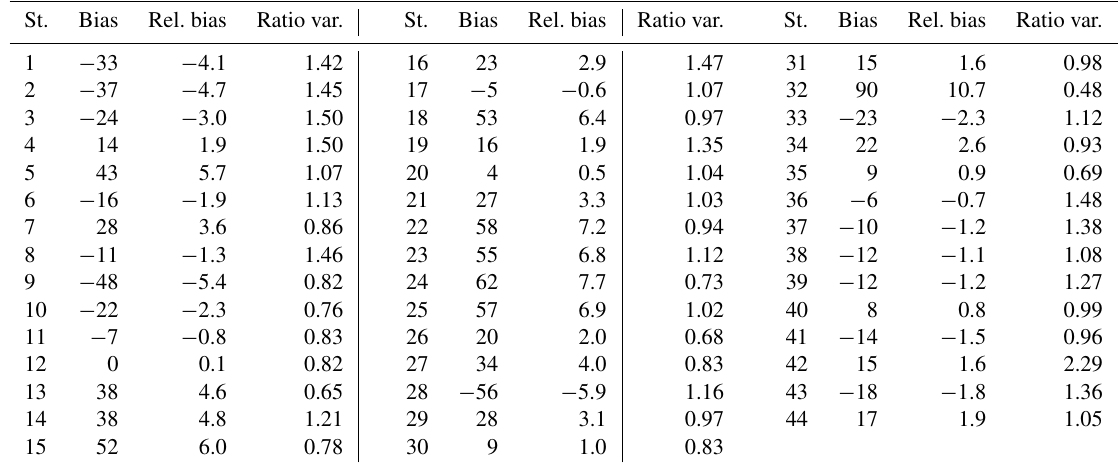
Table 7. Bias (inWm − 2 ) , relative bias (in %), and ratio of variances for B N at each station.